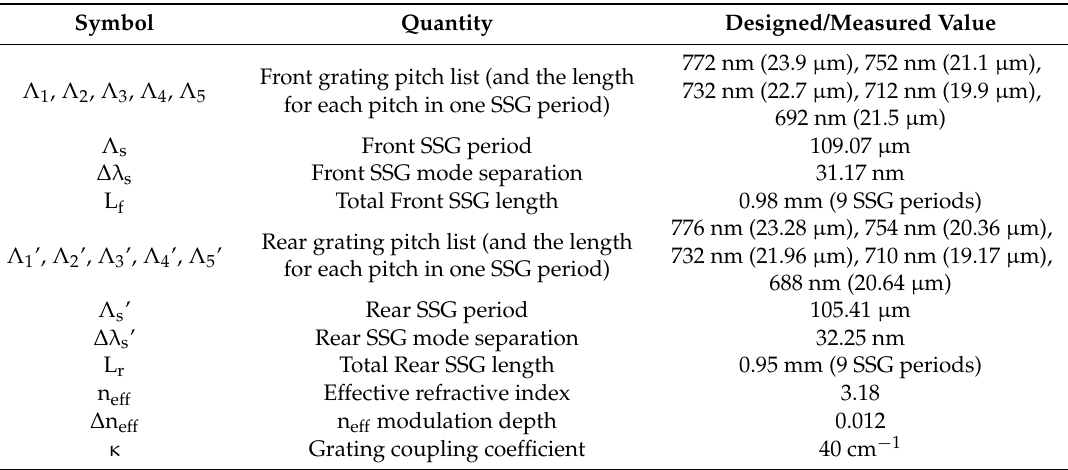
Table 1. Parameters of the designed 4.65 µ m